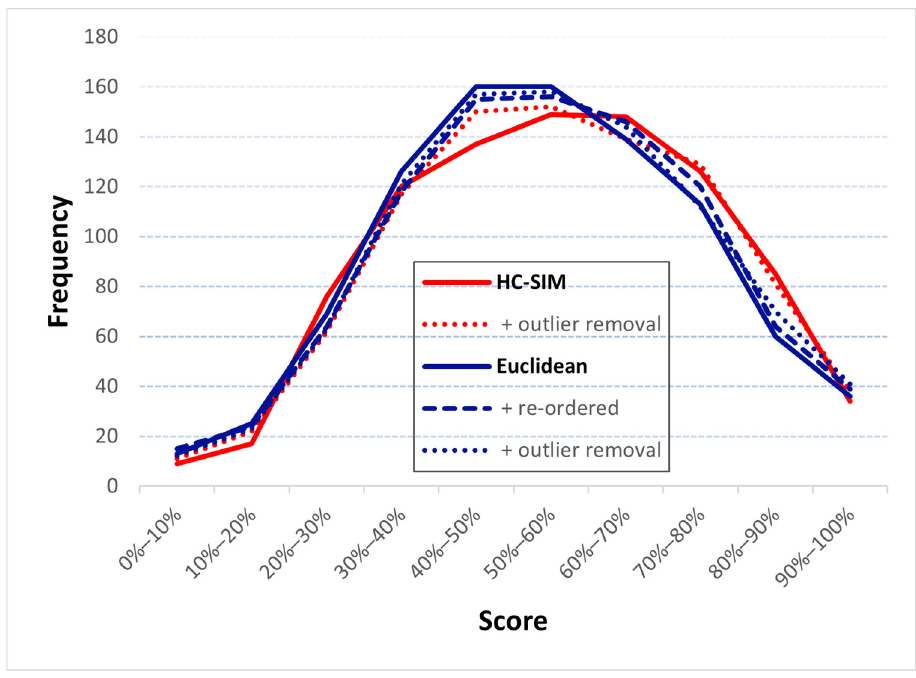
Figure 8. Frequency histograms of the scores when using HC-SIM (red) and Euclidean (blue). Table 4. Frequency distribution of the scores (901 test datasets) without